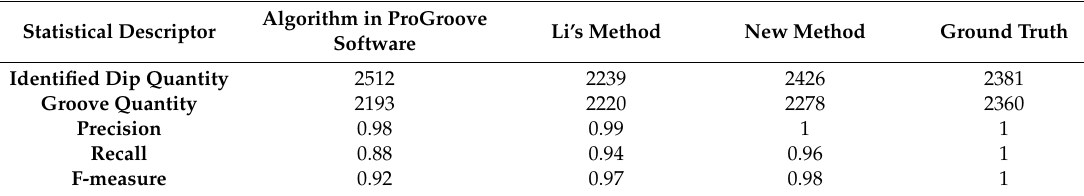
Table 4. Comparison of Groove Quantity Measurement Results.